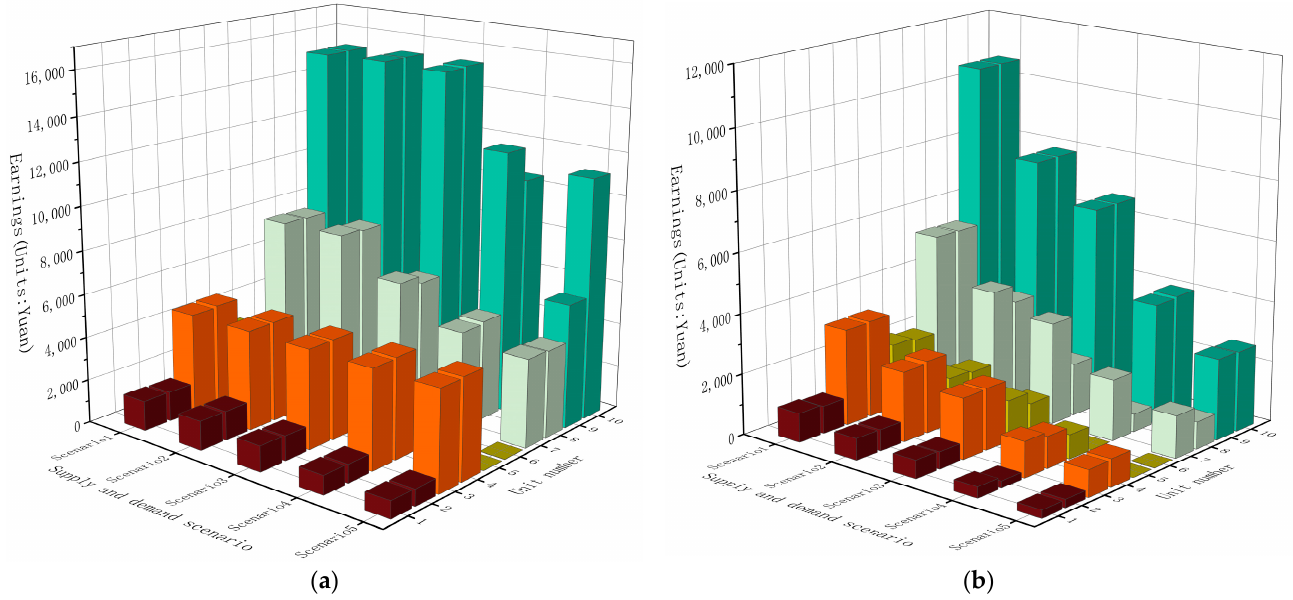
Figure 8. Bene fi ts of frequency regulation units when PAB ( a ) and MCP ( b ) are adopted in Si-